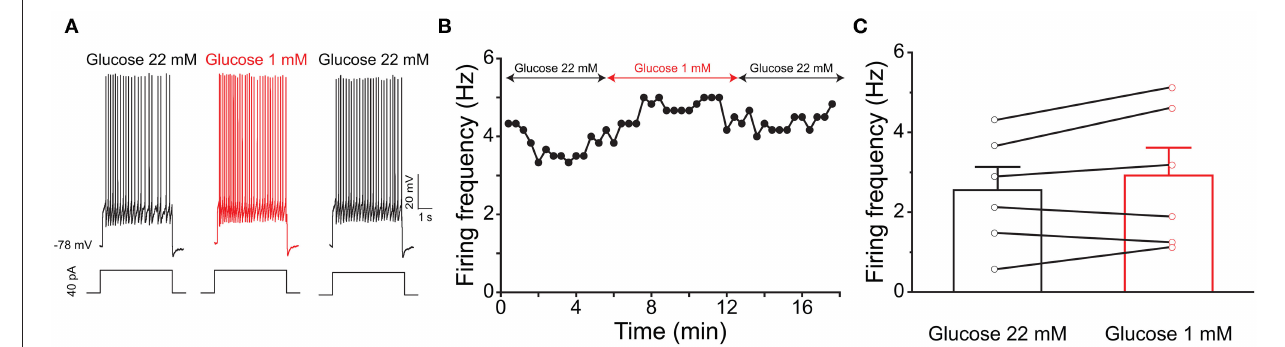
FIGURE 8 | PPG neurons are not glucose sensitive. (A) Representative current-clamp recording elicited by injecting a perithreshold current of 40pA with a pulse duration of 5s in 18s intervals. A baseline recording of 6min was acquired for the PPG neuron under control ASCF conditions (22mM) before switching to a bath application of low glucose (1mM) for 6min, followed by a return to original control ASCF for 6min. (B) Line graph of the cell in (A) plotting action potential firing frequency over time. (C) Bar/line graph of the mean spike frequency changes for 6 of 16 sampled PPG neurons that had a change of at least 0.5Hz following low glucose. Not significantly-different from baseline and wash, one-way RM ANOVA with Tukey’s post-hoc test, p >